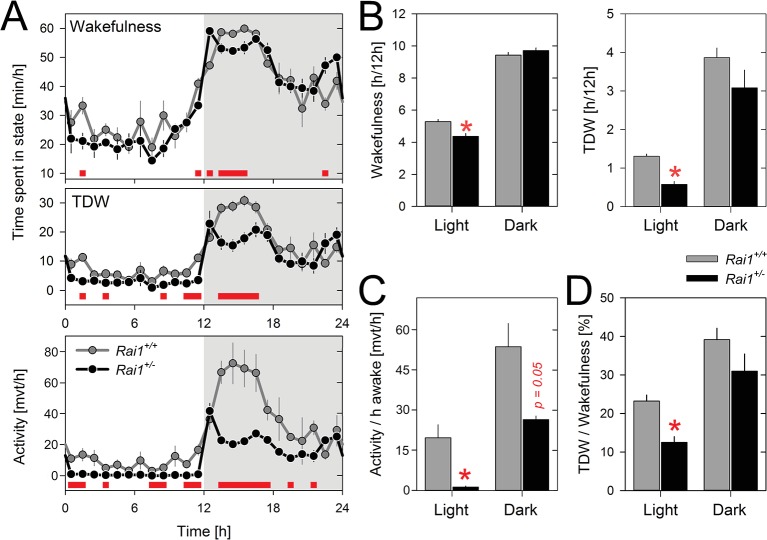
Theta-dominated wakefulness (TDW), but not total time-spent-awake, is profoundly suppressed by light in Rai1+/- mice.(A) Average profile of mean 1 hr values of wakefulness (total wakefulness including TDW), TDW (middle), and locomotor activity (bottom panels) under LD12:12 conditions (n = 4/genotype). Values of two 24 hr baseline days were averaged. Although Rai1+/- mice are awake longer than their littermates immediately after dark onset and before light onset, the two genotypes did not differ in time-spent-awake over 24 hr. TDW and activity levels were, however, generally below those observed in wild-type mice (red bars; p<0.05; t-tests). Note that while Rai1+/- mice did not show any evidence of dark anticipation in TDW and locomotor activity, we did observe this for wakefulness. In wild-type, levels of wakefulness, TDW, and activity all increase in the hour preceding dark onset. (B) Although 24 hr values of total time-spent-awake did not differ between genotypes, we did observe a slight, but significant reduction in Rai1+/- mice during the 12 hr light period (*p<0.05, t-test; left panel). Similarly, TDW levels in the light were reduced (*p<0.001; t-test, right panel) but unlike for wakefulness, we did observe an overall reduction in TDW (p<0.05; t-test), compared to wild type. (C) Number of movements expressed per hour of total wakefulness were profoundly reduced in Rai1+/- mice, especially during the light phase (*p<0.001; t-test) and (D) this result was paralleled by a reduction in TDW expressed as a percentage of total wakefulness during the light period, in Rai1+/- mice (*p<0.05; t-test). Error bars represent SEMs.DOI:
http://dx.doi.org/10.7554/eLife.23292.00510.7554/eLife.23292.006Figure 2—source data 1.Twenty-four hour values for total wakefulness, theta-dominated wakefulness (TDW), NREM sleep, and REM sleep under LD12:12 conditions.n = 4/genotype.DOI:
http://dx.doi.org/10.7554/eLife.23292.00610.7554/eLife.23292.007Figure 2—source data 2.Excel file with data sheets corresponding to each figure panel containing the numerical values on which the Figure 2 graphs are based.For all panels individual data are provided as well.